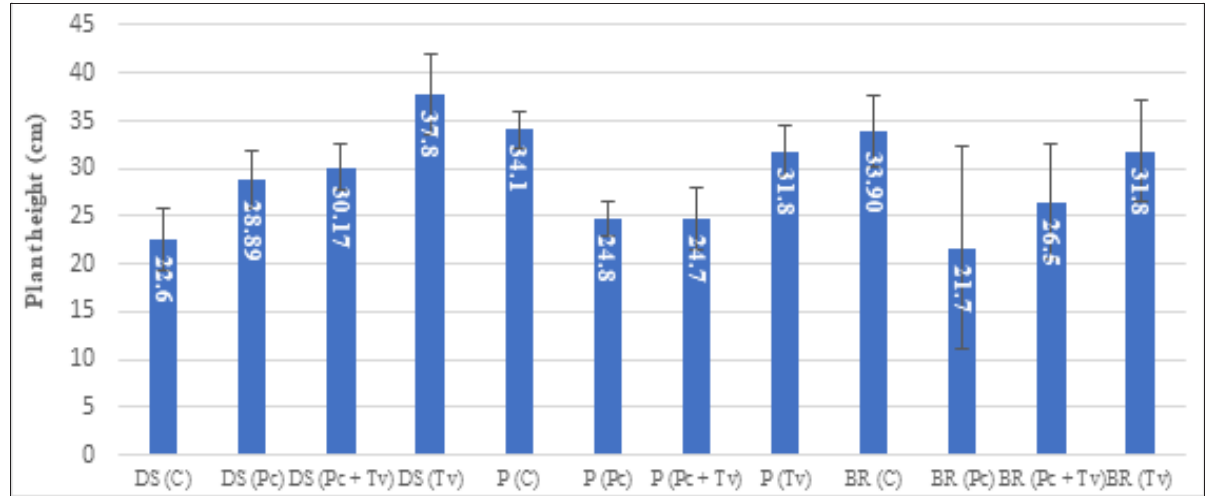
Figure 3: Plant height (cm), according to control treatments of P. capsici on T. viride under three methods ( α =